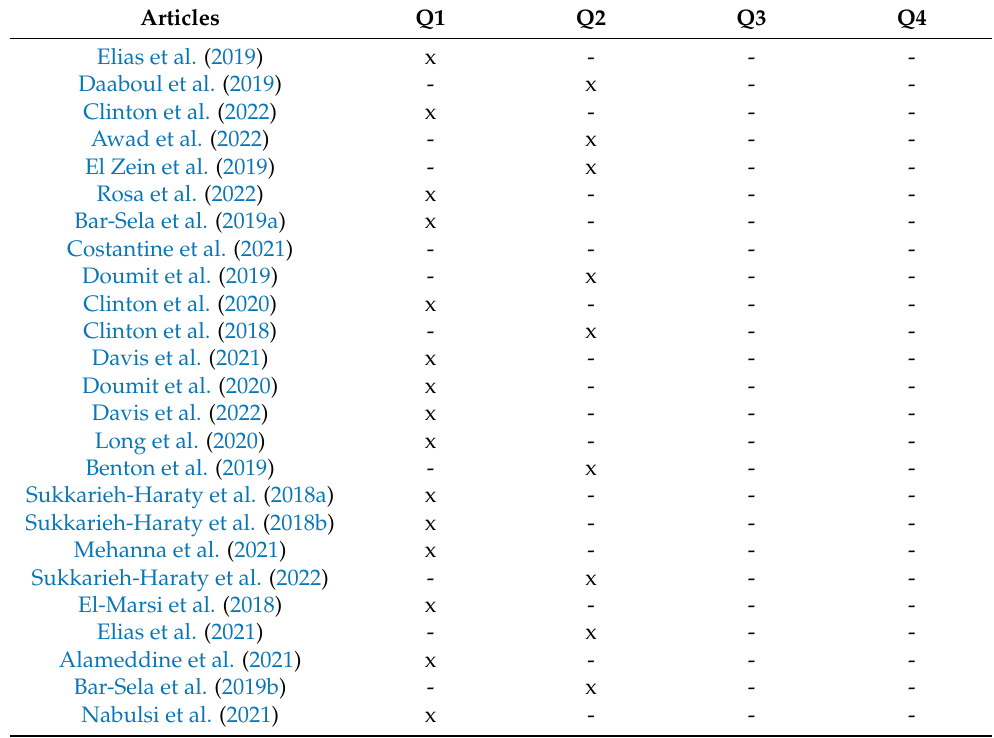
Table A6. Published papers in the School of Nursing,